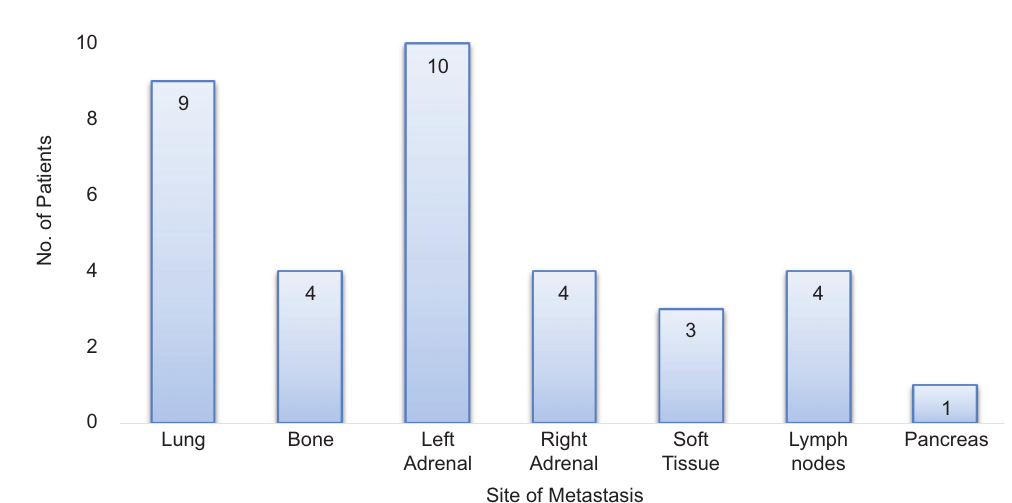
Figure 2: Distribution of location of distant metastases in nine patients with multiple sites of